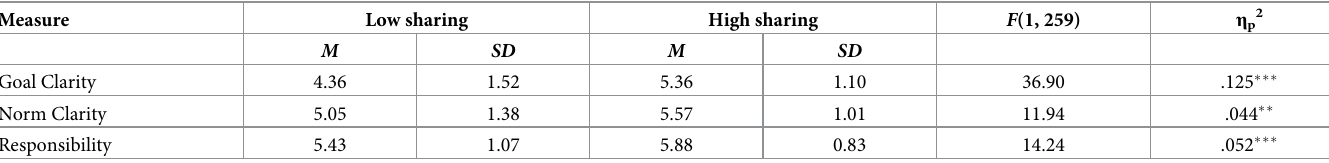
Table 7. Results of all three ANOVAs in Study 4 ( N = 261).